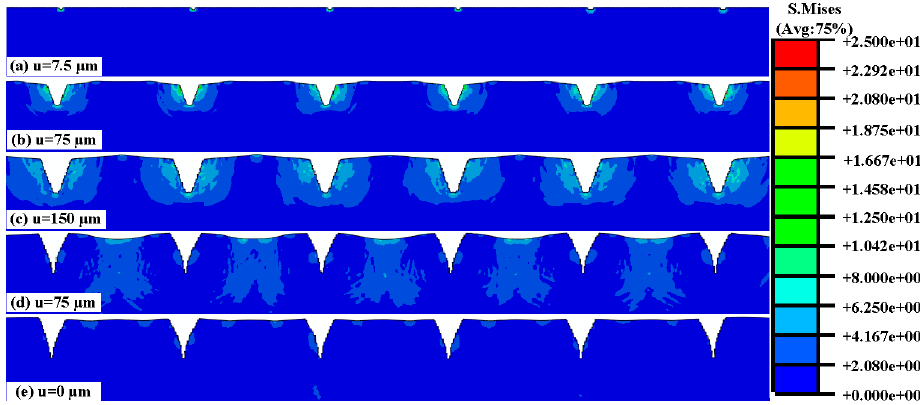
Figure 8. Stress distribution on human skin during the insertion and pull process.